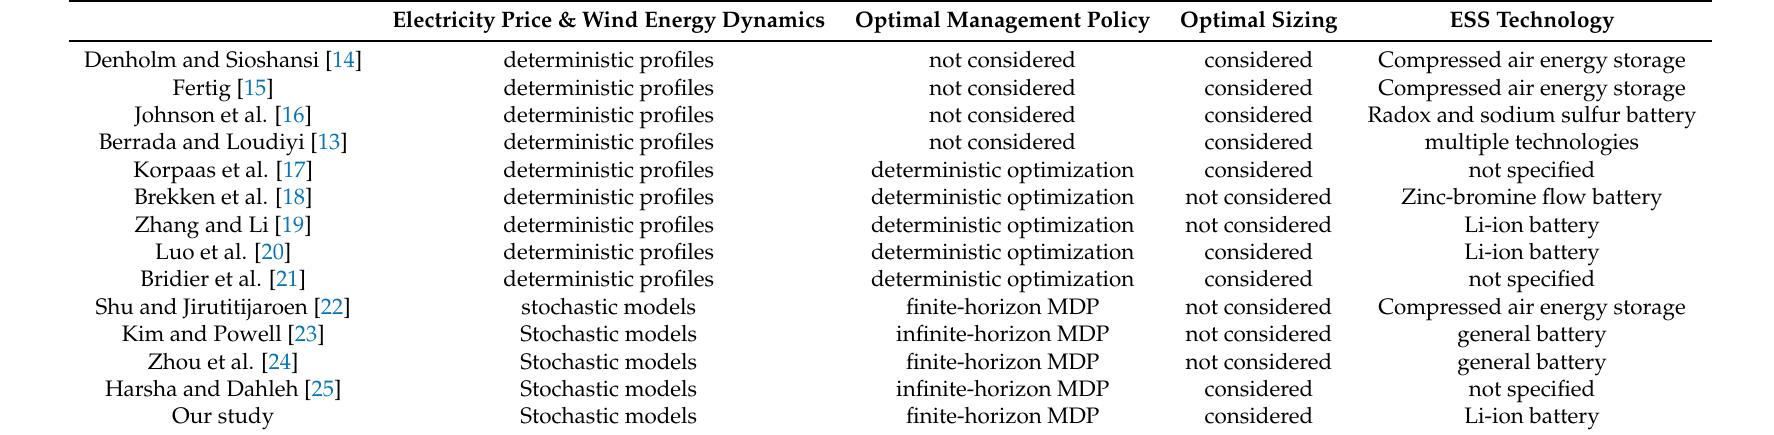
Table 1. The literature on optimizing an energy storage system (ESS) in a wind